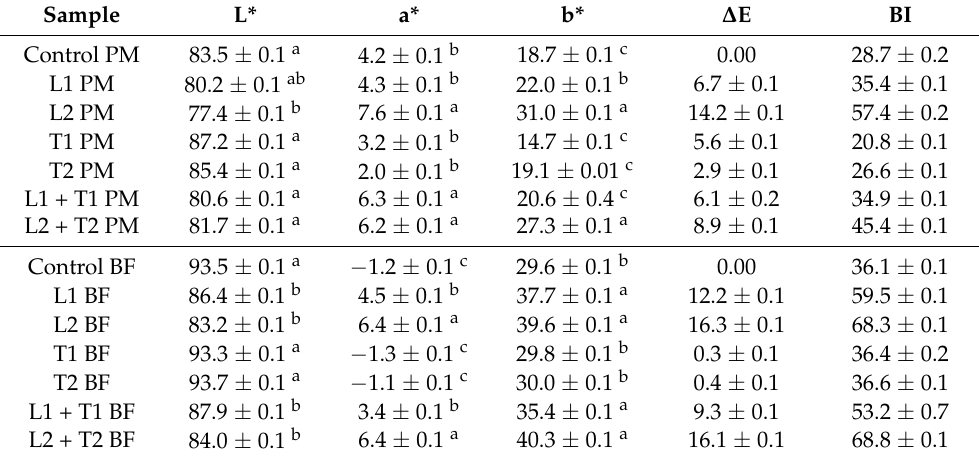
Table 2. Effect of different enzyme preparations (pure or combined enzyme activities) and dosages on the color characteristics (L*, a*, b*, and ∆ E*) and browning index (BI) of